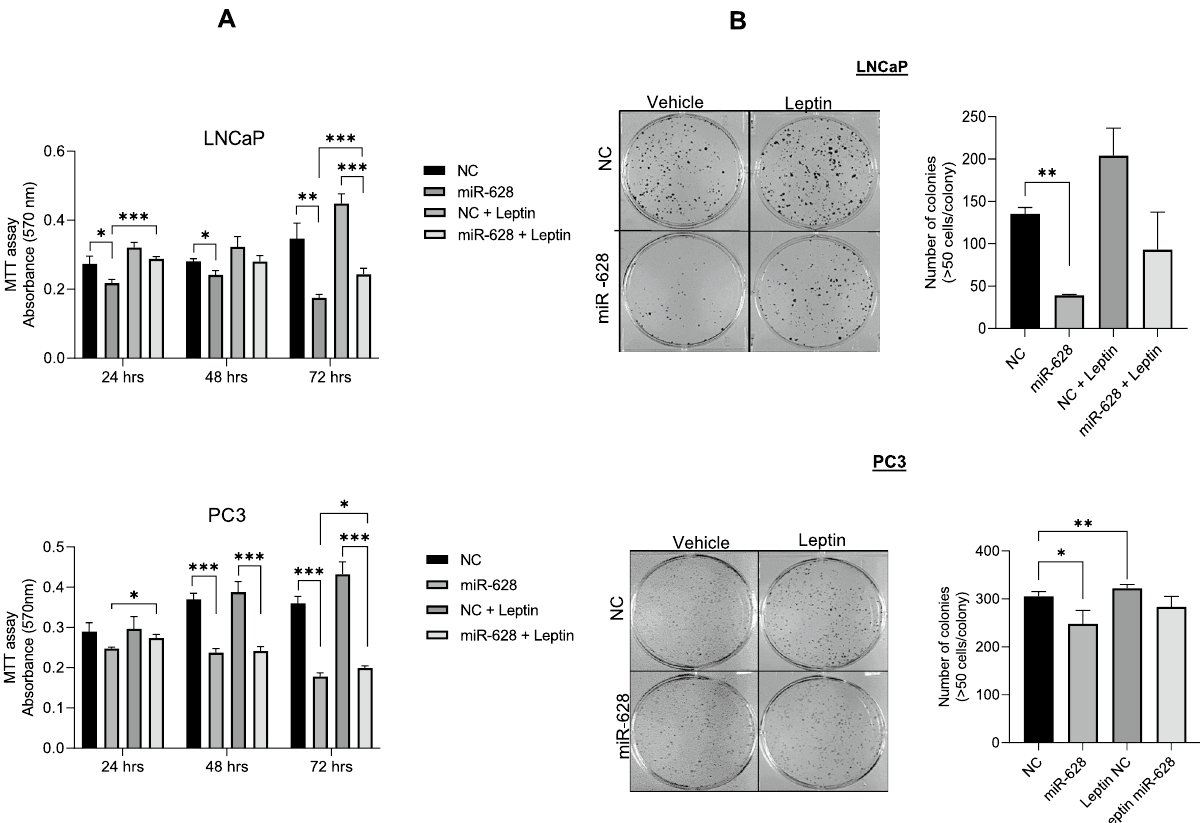
Figure 2. Leptin abrogates miR-628 impact on cell proliferation/colony formation in PCa cells. ( A ) LNCaP and PC3 cells were treated with 10 ng/ml of leptin or vehicle for 48 h and cell proliferation was analyzed using MTT assay in LNCaP and PC3 cells after transfection with 100 nM miR-628 mimic or NC and after treatment with 10 ng/ml of leptin or vehicle after 24, 48, and 72 h (upper and lower panels). *p < 0.05, **p < 0.01, ***p < 0.001. ( B ) Cell colony formation was assessed in LNCaP and PC3 cells transfected with 100 nM miR-628 mimic or NC and treated with 10 ng/ml or vehicle (left and right panels) *p < 0.05, **p <